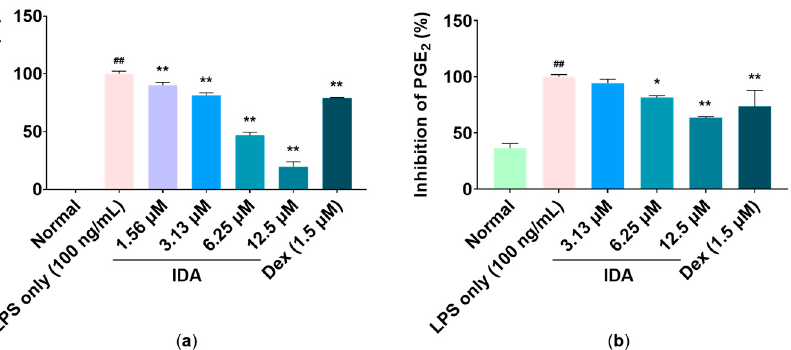
Figure 2. Effect of isodorsmanin A (IDA) on ( a ) nitric oxide (NO) and ( b ) prostaglandin E 2 (PGE 2 ) production in macrophages. Cells were pretreated with IDA (1.56, 3.13, 6.25, or 12.5 µ M) for 3 h and then stimulated with 100 ng/mL of LPS for another 21 h. The experimental values are presented as the mean ± standard error of triplicate independent experiments. * p < 0.05 and ** p < 0.01 indicate significant differences vs. the LPS-only group. ## p < 0.01 indicates significant difference vs. Normal group. Dexamethasone (Dex); positive control.